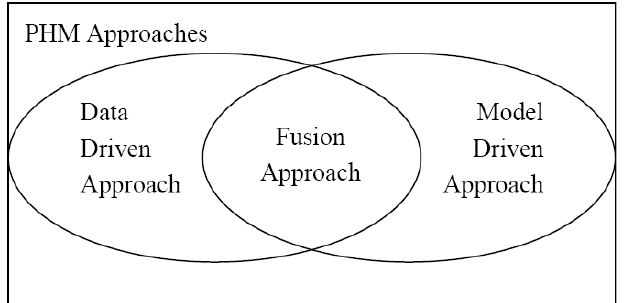
Figure 1. Prognostics and health management